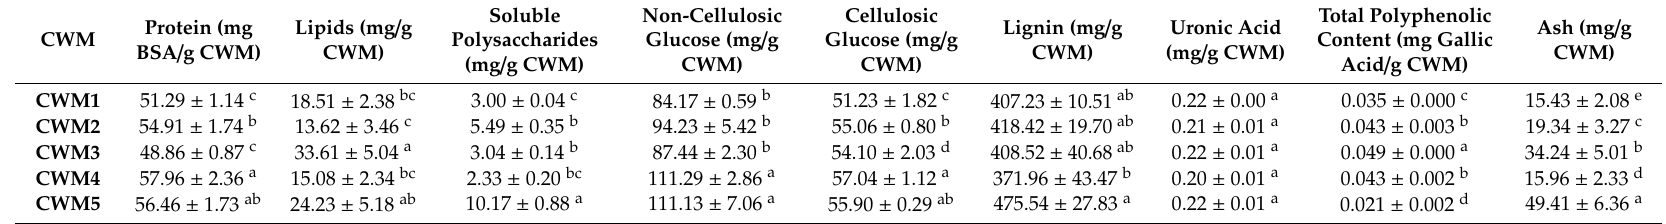
Table 1. CWM composition. CWM 1–5 as defined in materials and methods. Di ff erent letters indicate significantly di ff erences within a column using Fisher test p < 0.05 ( n =